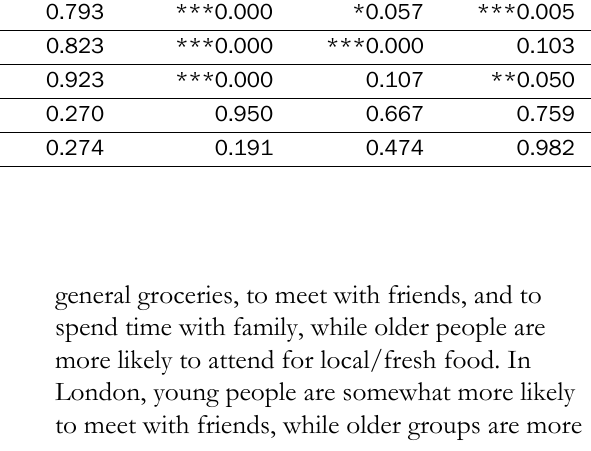
Table 3. Customer Purchasing and Motivations by Market